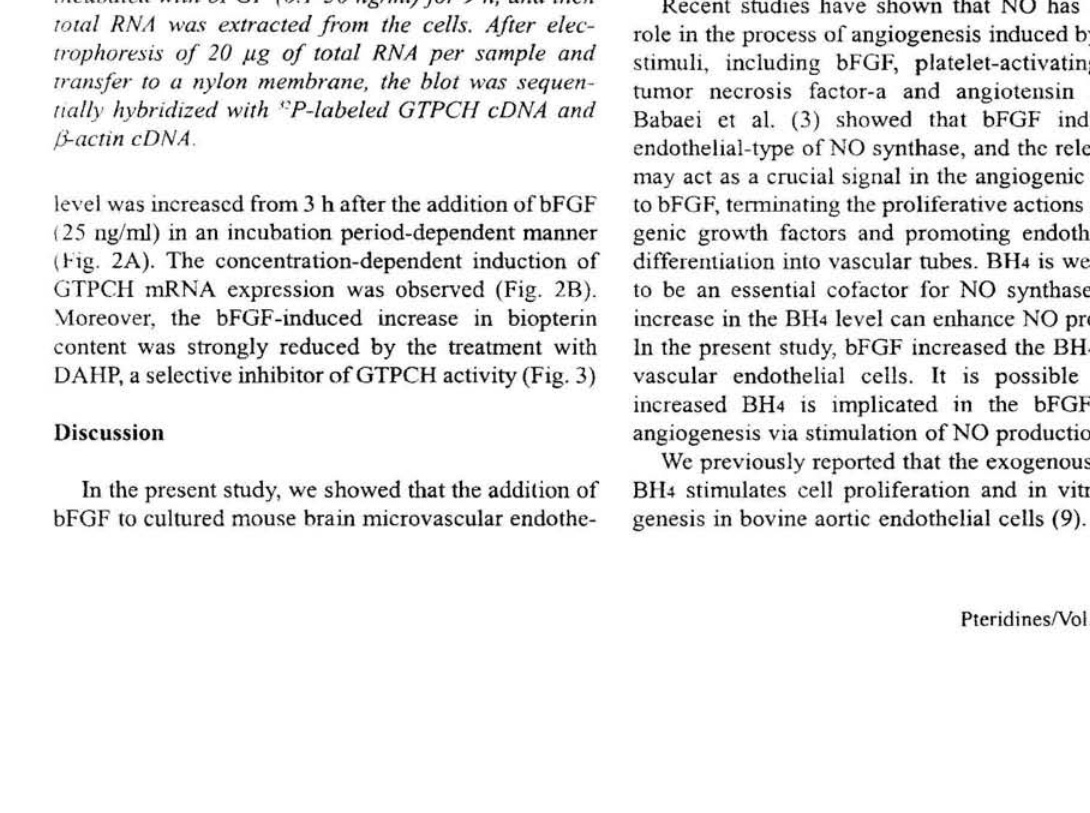
Figure 3 Effect of GTPCH inhibitor an the bFGF- induced increase in biopterin content. Cells were incu- bated with bFGF (25 ng/ml) in the presence or absence of DAHP (10 1,000 mM) for 24 h. Values are the means + S.E.M. of 4 experiments. #Significantly different from the bFGF ahne group